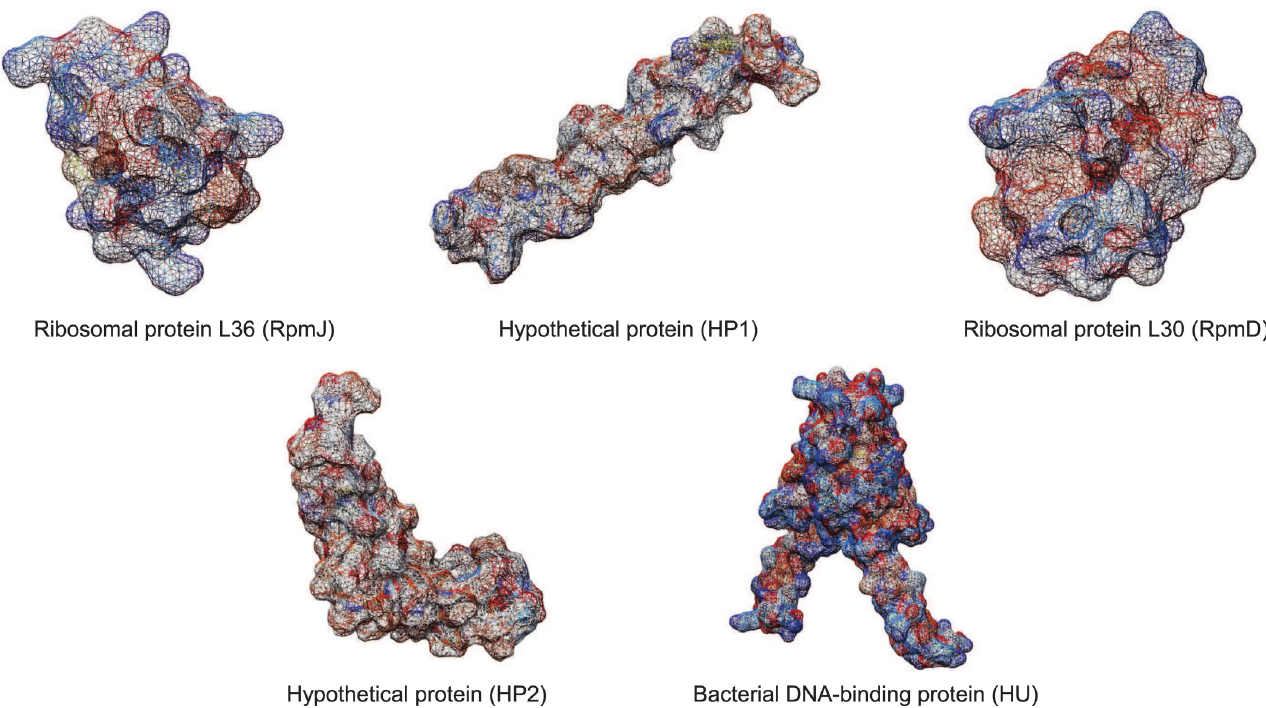
Fig 5. 3D structures of the five proteins found to correspond to the MALDI-TOF spectral peaks recognized as discriminant between benzylpenicillin resistant and susceptible isolates. Top row from left to right: homology model of ribosomal protein L36p (RpmJ, mw: 4305.36Da), threading model of hypothetical protein (HP1, mw: 4801.95Da) and homology model of ribosomal protein L30p (RpmD, mw: 6422.48Da). Bottom row from left to right: threading model of hypothetical protein (HP2, mw: 6901.37Da) and homology model of bacterial DNA-binding protein (HU, mw: